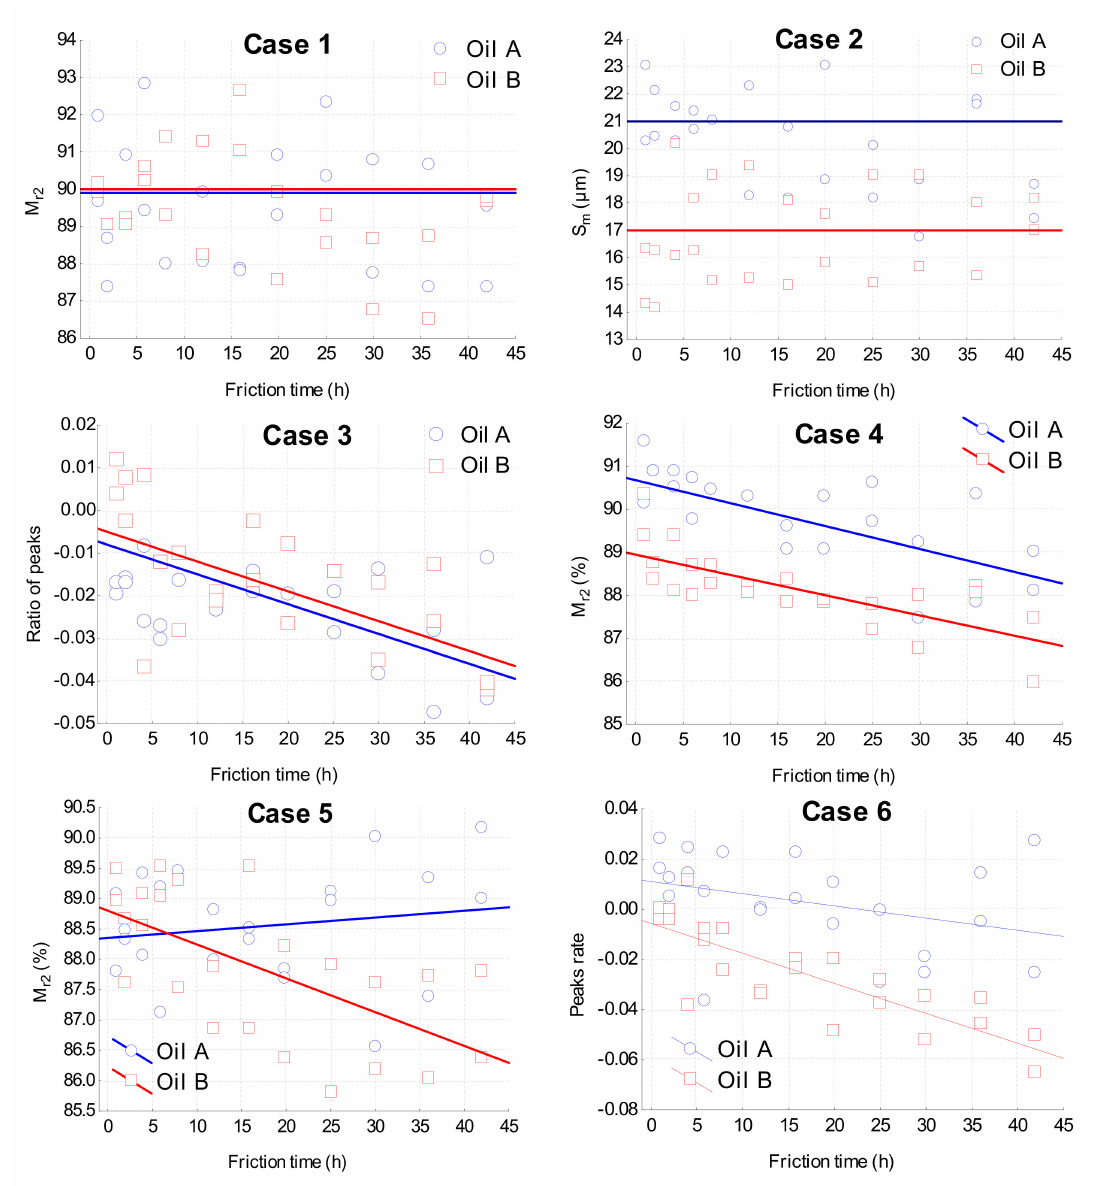
Figure 4. The di ff erent cases of ANCOVA